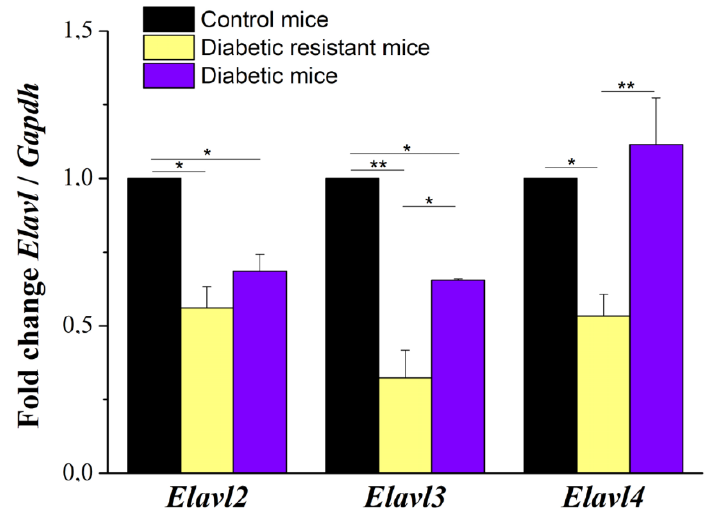
Figure 3. Paw withdrawal latencies (in s) in response to radiant heat (55 °C). Initial (L0) and final (Lf) withdrawal latencies were represented as mean ± SD for control, diabetic resistant, and diabetic mice. Statistical significance is indicated *** p < 0.001.